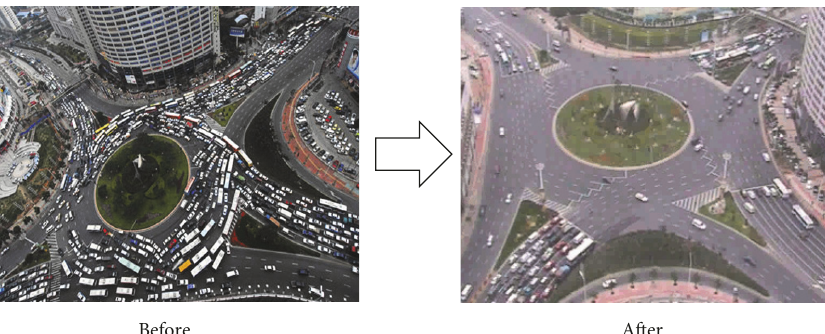
Figure 1: A before-and-after scenario by using the TSLSR.